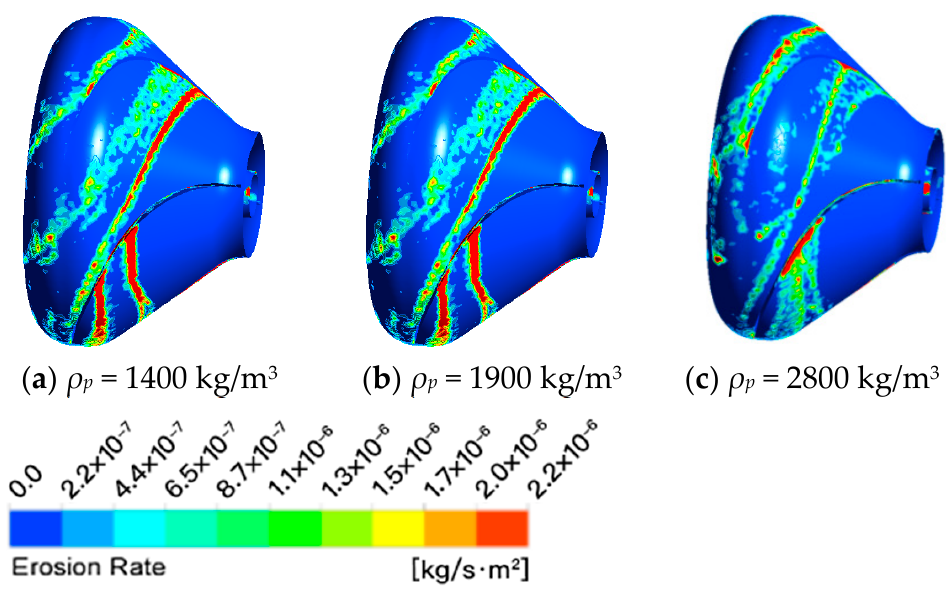
Figure 16. Wear rate changes on the surface of the through-passage components.